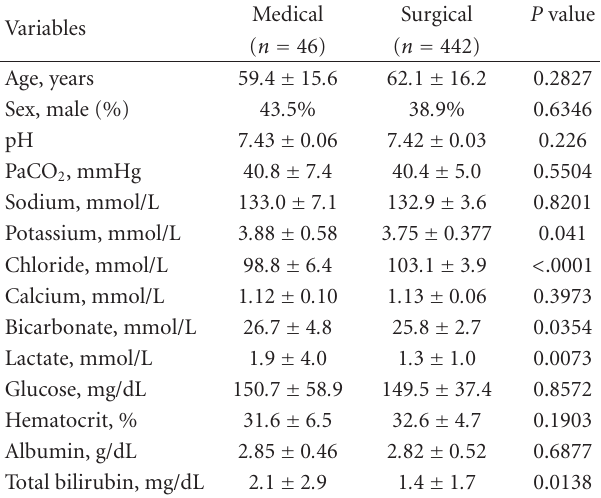
Table 6: Comparison of variables between medical and surgical